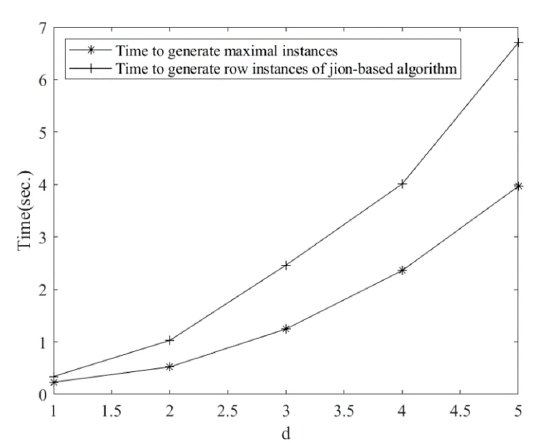
Figure 11. The effect of 𝑚𝑖𝑛 _ 𝑑 on the running time .